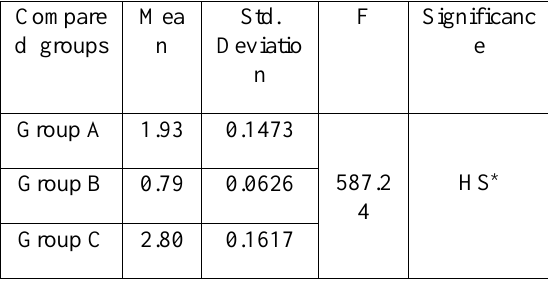
Table 4: Group by group comparison using